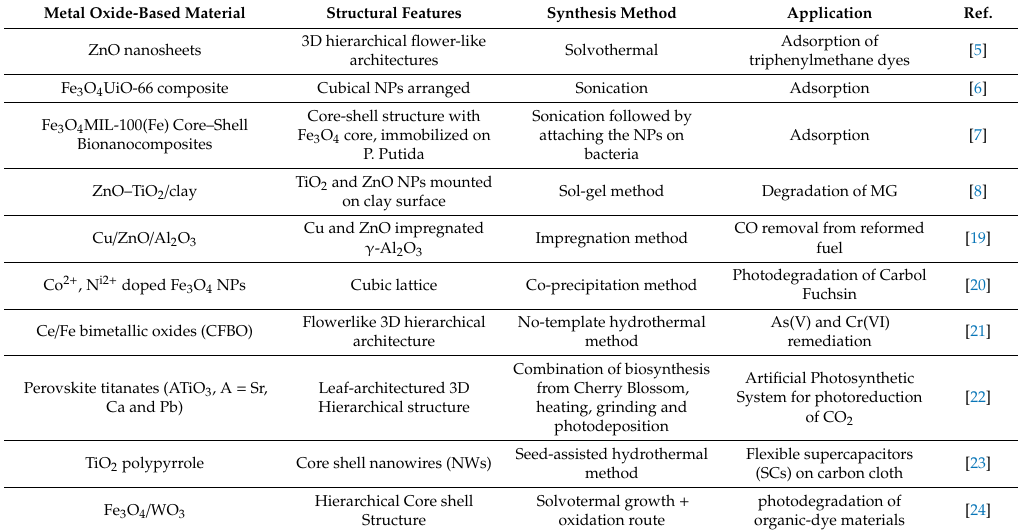
Table 1. Applications of some representative metal oxide-based materials with various structures.